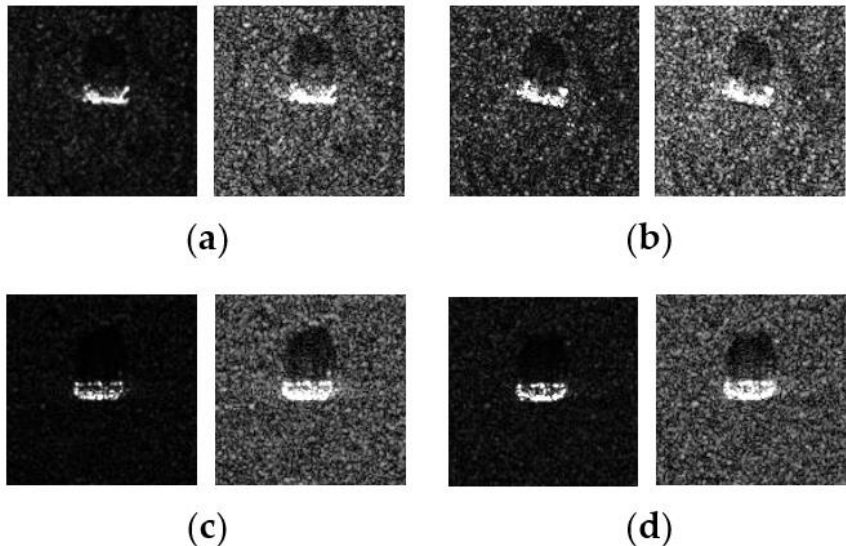
Figure 7. Difference between the image samples from the MSTAR-P dataset (left) and those from the MSTAR-O dataset (right). ( a ) BRDM2 (El =15°, Az = 95°); ( b ) BRDM2 (El =15°, Az = 105°); ( c ) BTR60 (El = 15°, AZ = 270°); ( d ) BTR60 (El = 17°, AZ = 270°).